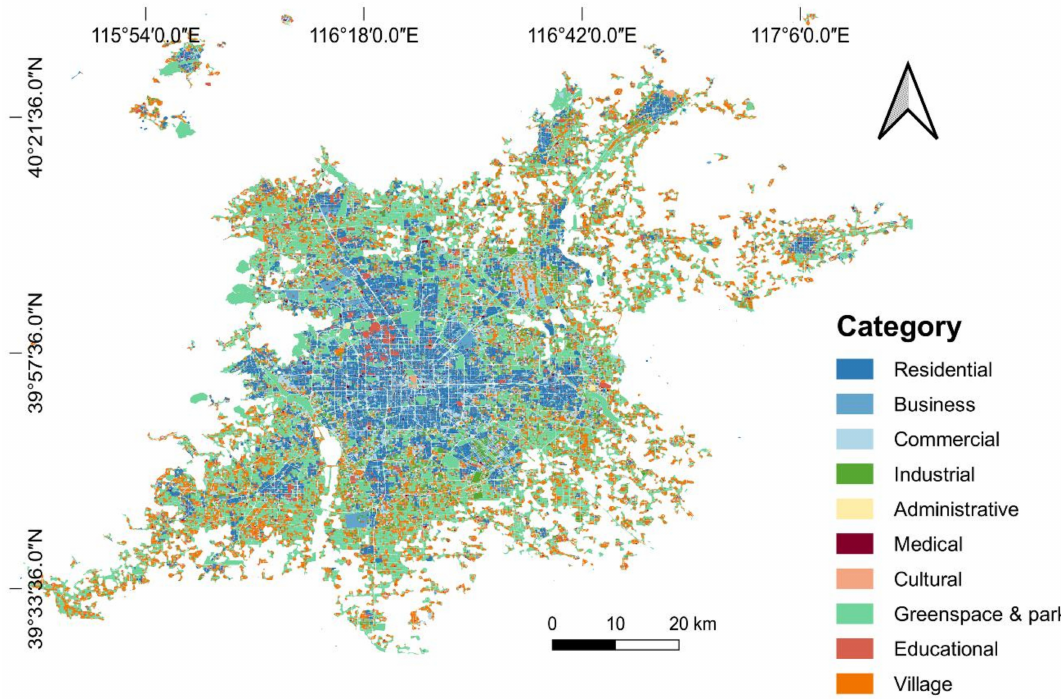
Figure 10. Map of EULUC-AOI (OSM+200 m grid) in Beijing,